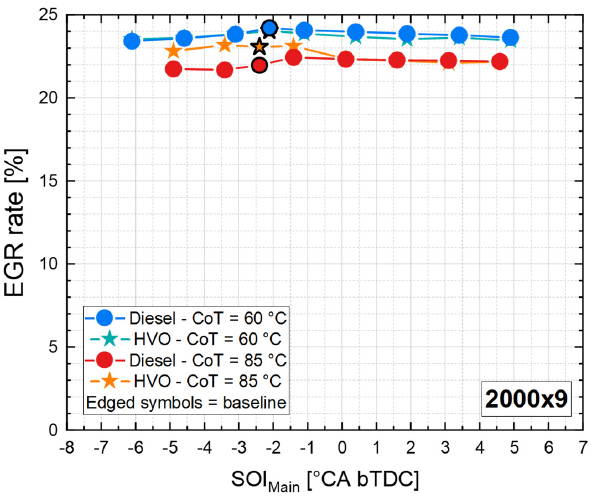
Figure 9. EGR rate along SOI Main sweep tests at 1250 × 2 and 2000 × 9. Comparison between diesel and HVO at high and low coolant temperatures. Warm colors represent high coolant temperatures, while cool colors represent low coolant temperatures. Circles represent diesel, while stars represent HVO.